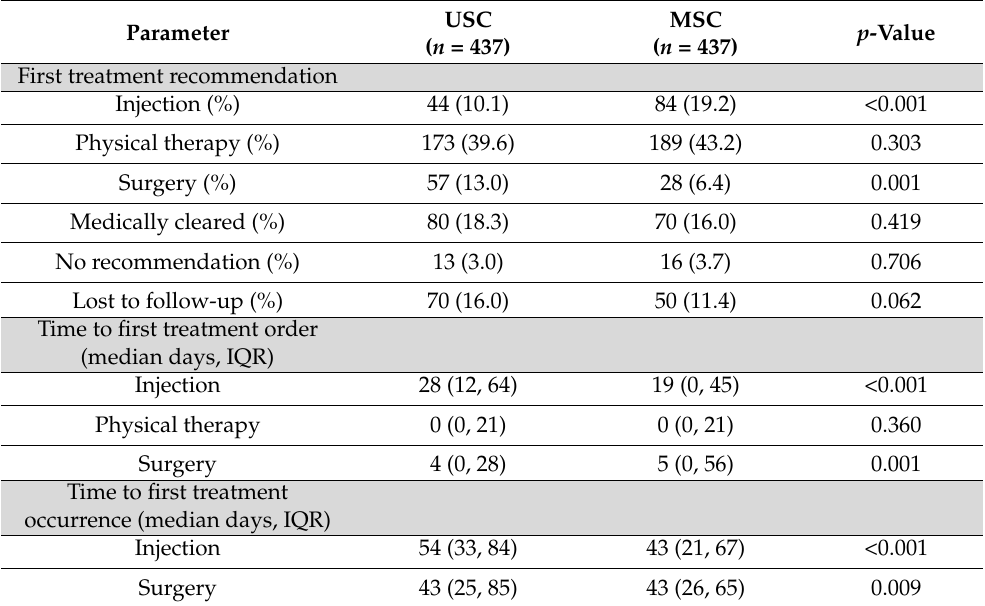
Table 3. Propensity score-matched analysis of treatment recommendations in patients seen at the Unidisciplinary Spine Clinic (USC) and Multidisciplinary Spine Clinic (MSC).